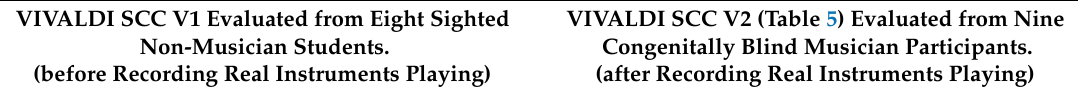
Table 7. User feedback for VIVALDI SCC V1 and VIVALDI SCC